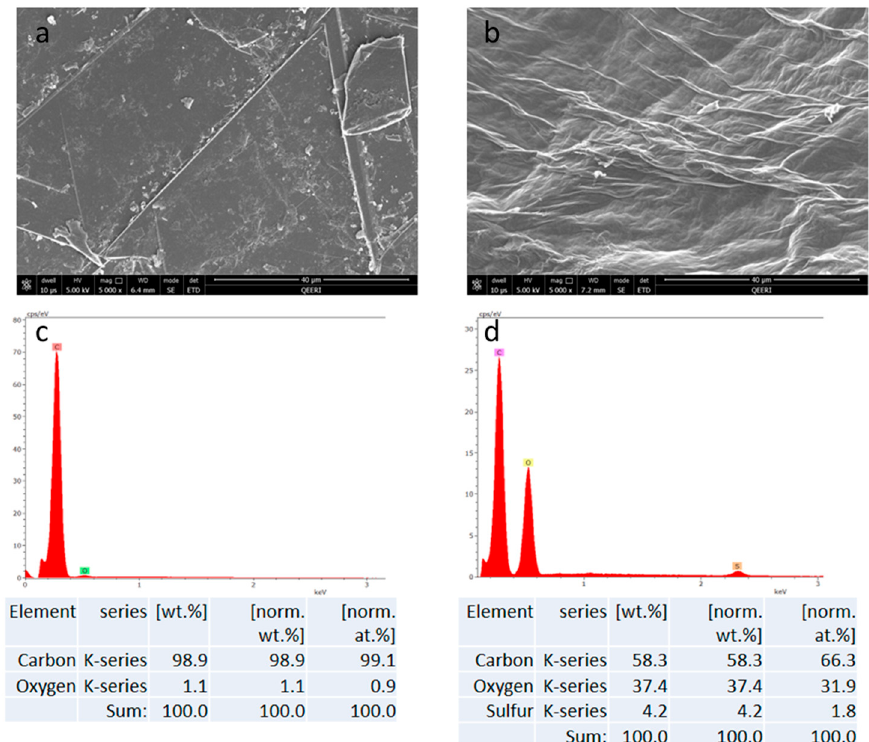
Figure 1. SEM (scanning electron microscopy) images for graphite flakes ( a ), GO flakes ( b ), EDX (energy-dispersive X-ray spectroscopy) mapping for graphite and GO ( c , d ), respectively.